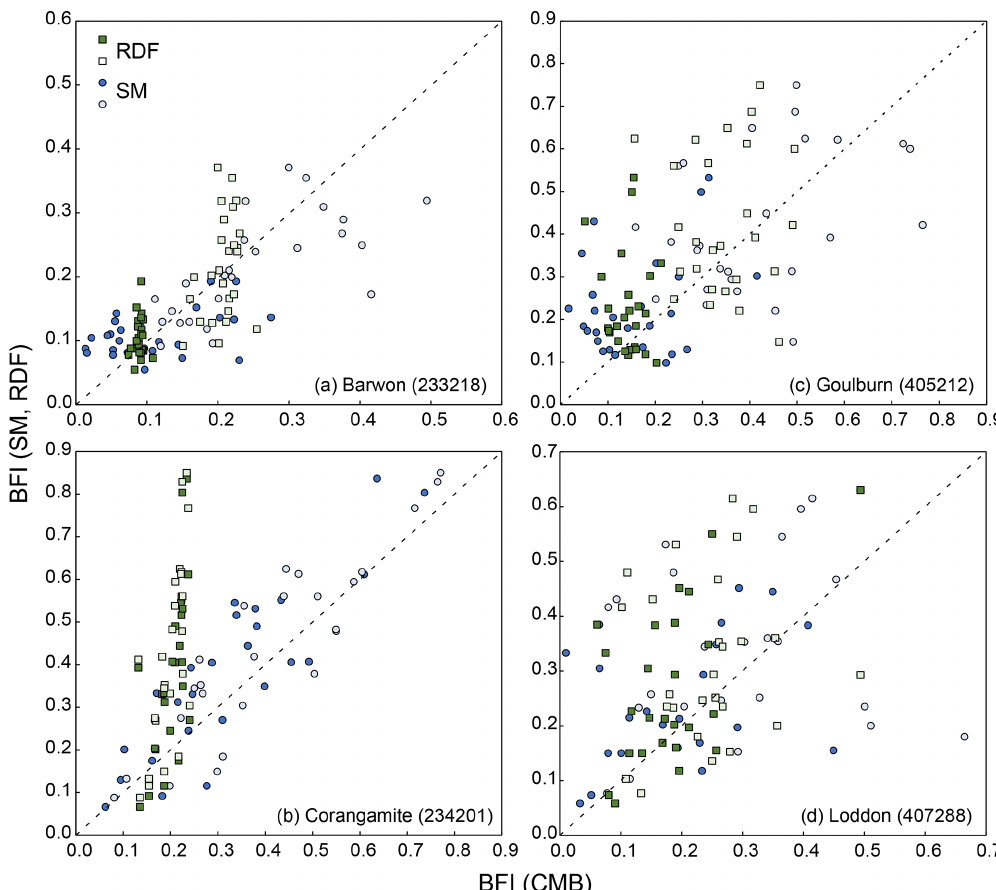
Figure 5. Comparison of annual BFI estimates calculated from the RDF and SM methods with that from the CMB using the variable (open symbols) and constant (closed symbols) SC b approach for one station in the Barwon (a) , Corangamite (b) , Goulburn (c) , and Loddon (d) catchments. Dashed lines are the 1 : 1 relationship.